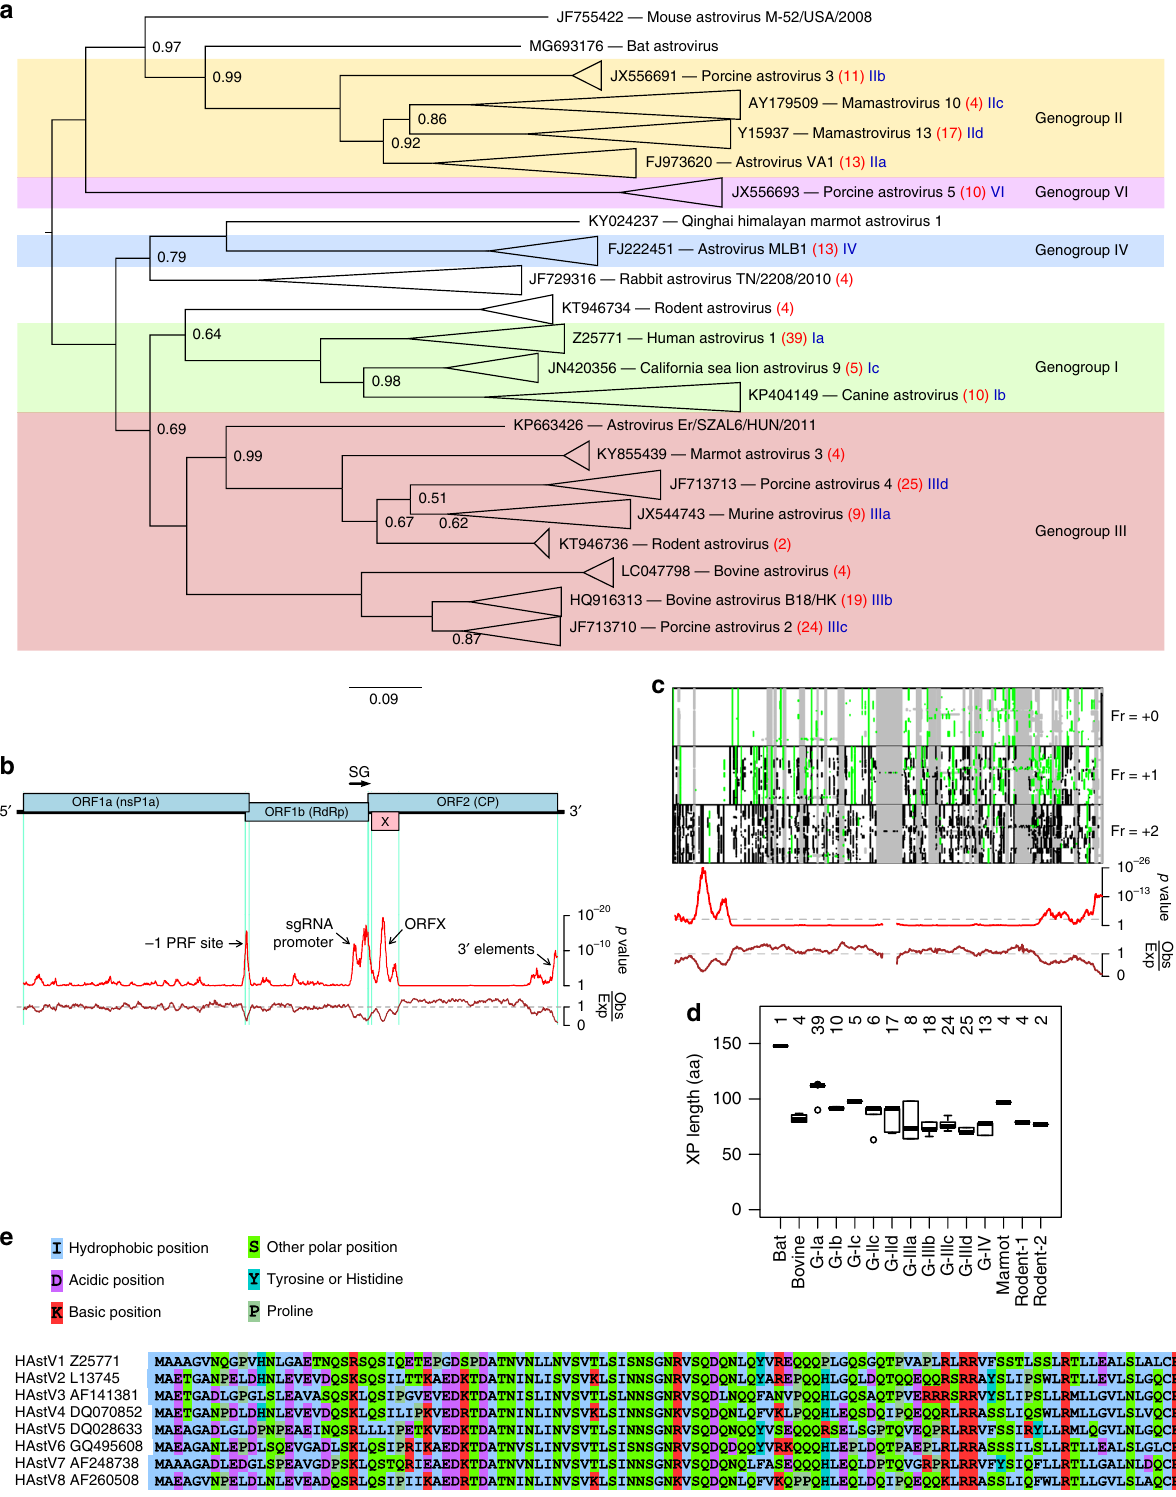
viability of the tagged viruses. Thus we turned to ribosome pro- fi ling (Ribo-Seq). Ribo-Seq is a high-throughput sequencing technique that globally maps the footprints of initiating or elongating 80S ribosomes on mRNAs 12,13 . We infected Caco2 (human epithelial colorectal adenocarcinoma) cells and per- formed Ribo-Seq at 12 h post infection (hpi). Ribo-Seq quality was assessed as previously described 14 (Supplementary Fig. 10).